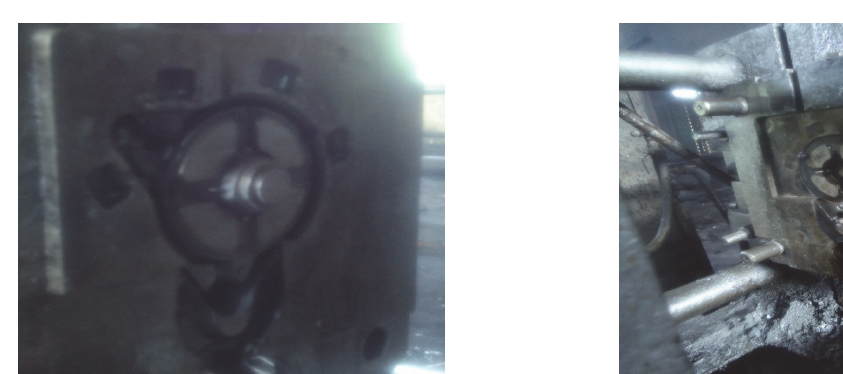
Fig. 4. Process Flow Chart